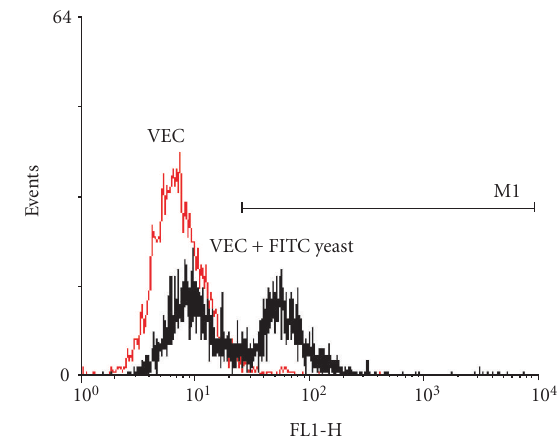
Figure 4: FITC-stained yeast binding to VEC is illustrated. VEC alone have significant autofluorescence as indicated by the gray his- togram. When stained, yeast become attached to VEC providing a second fluorescent peak at a level approximately one log greater than VEC autofluorescence.